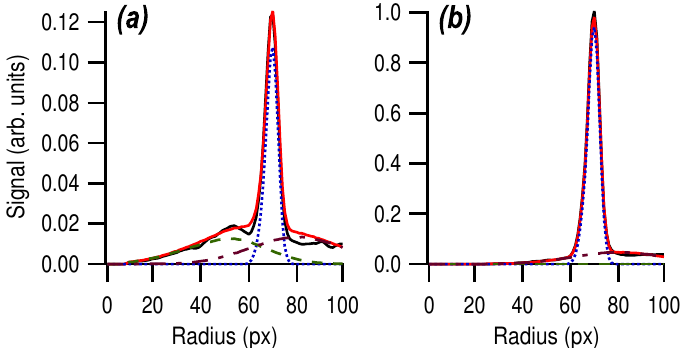
Figure 5. I*( 2 P 1/2 ) fragment velocity distributions (in pixels) at ( a ) 120 fs and ( b ) 10 ps delay times. The experimental data ( - ), the fitted total ( - ) and the fitted different contributions (main ( · · · ) and secondary ( - - and ·− )) are